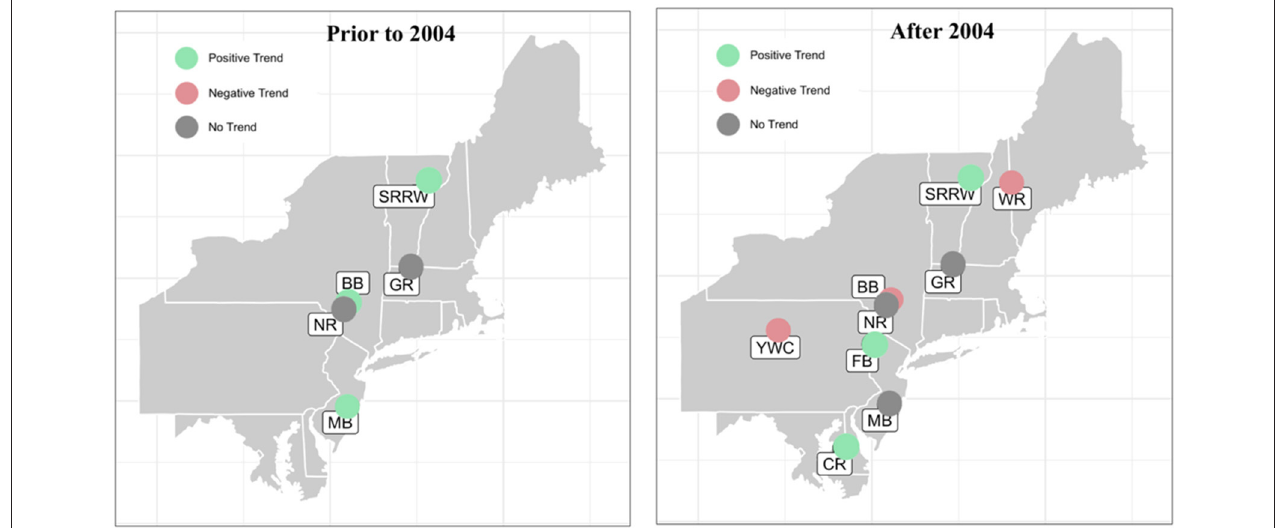
FIGURE 4 | Directionality of catchment flow adjusted dissolved organic carbon concentration (DOC FA ) trends prior to ( n = 5) and after ( n = 9) 2004. Statistically significant ( α ≤ 0.05) positive trends are shaded in green, statistically significant negative trends are shaded in red, and no trend are shaded in